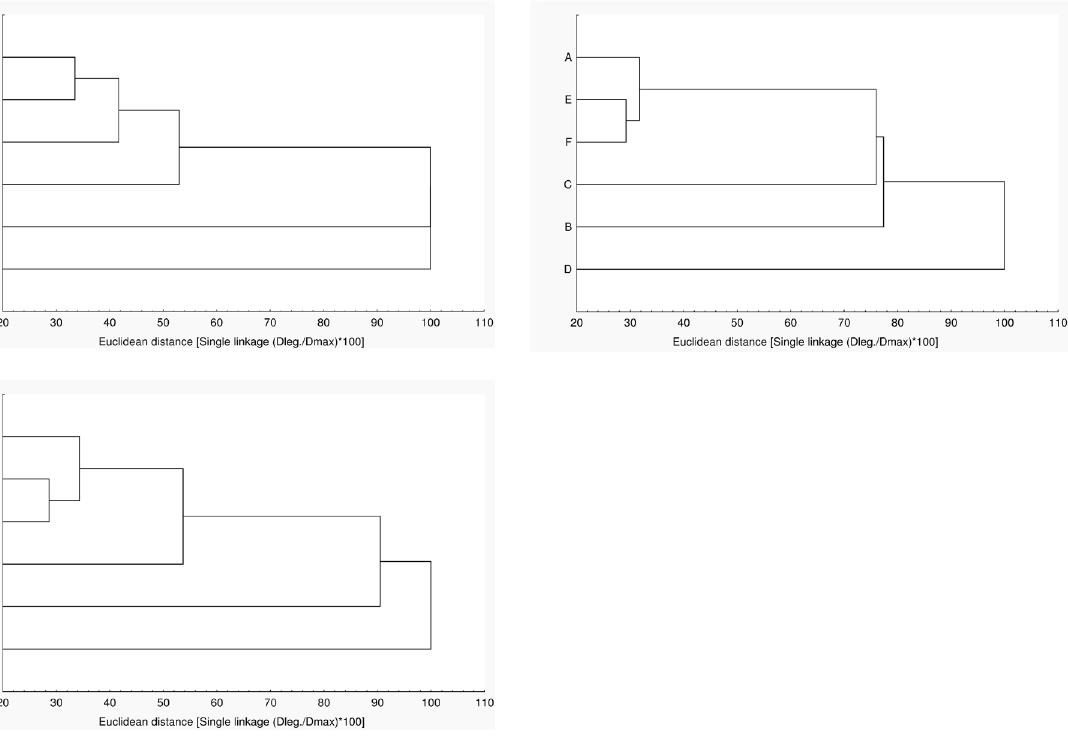
Fig. 1. UPGMA dendrogram showing the dissimilarities among habitat types based on amphibian species composition. (A) wet and dry seasons cumulated, (B) only wet season, (C) only dry season.